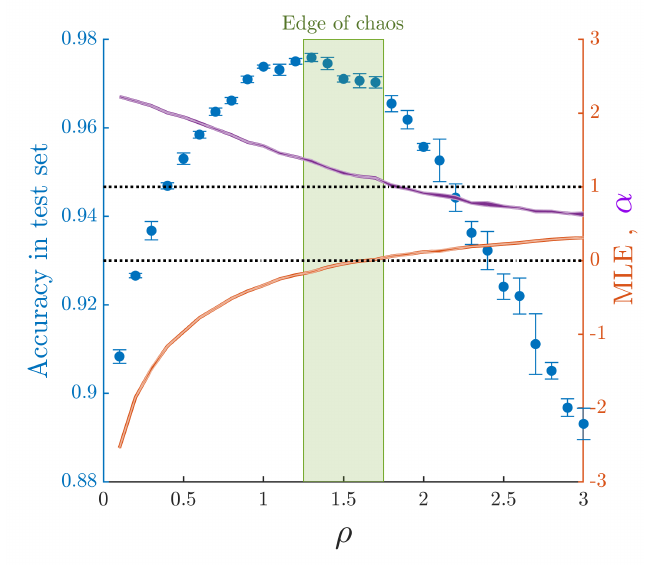
Figure 4. Curves for the accuracy in MNIST testset (blue dots), maximum Lyapunov exponent (orange line) and best-fit exponent for a power-law spectrum of the activity covariance matrix (purple line). Training was performed over 20,000 randomly chosen images of the MNIST training dataset, while classification error was assessed over the full test set (10,000 images). Errors in each case were estimated as the standard deviation from the mean over ten different initializations of the